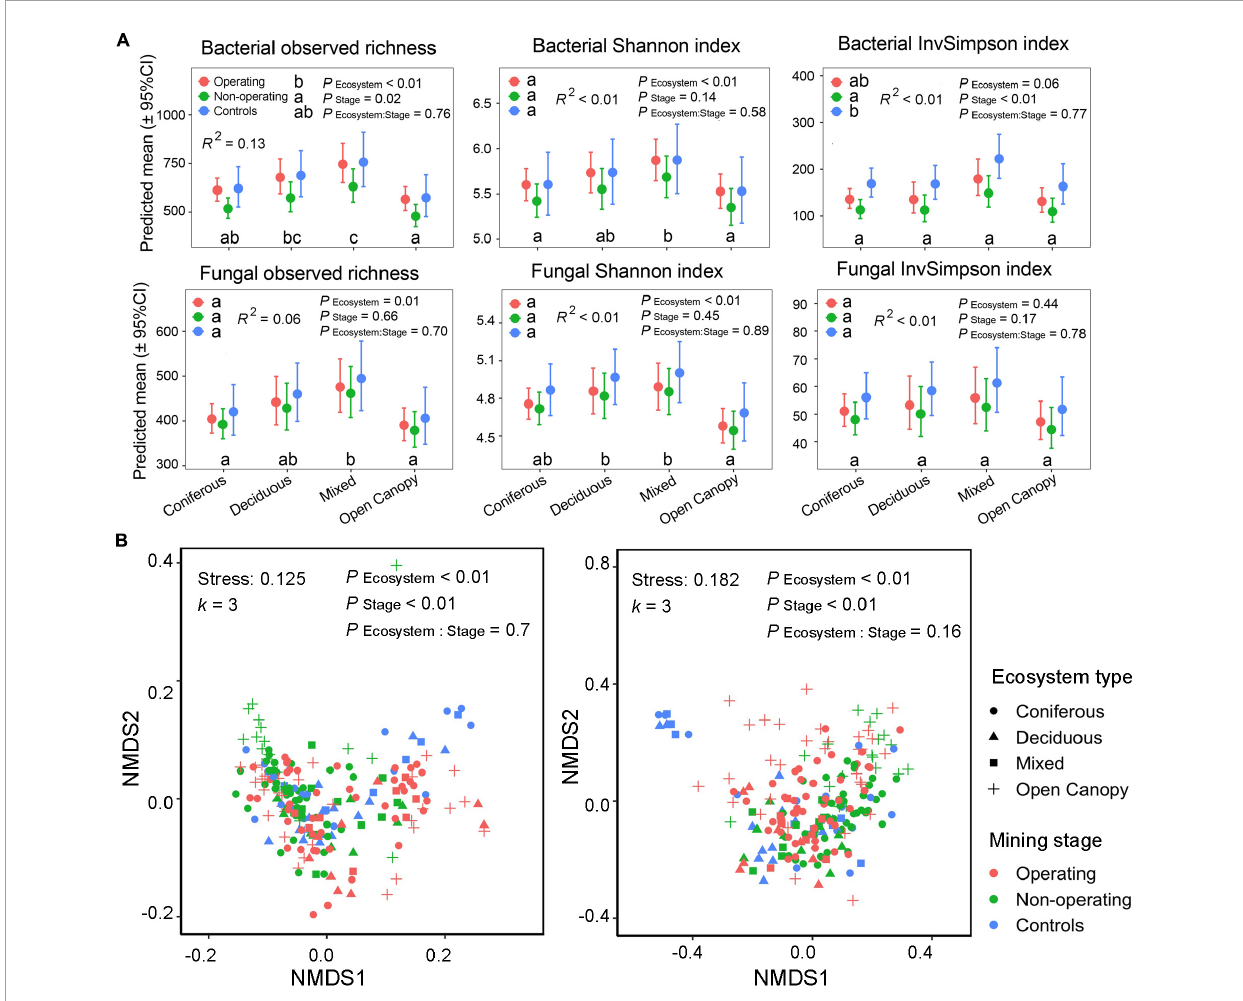
FIGURE2 Changes in the phyllosphere alpha and beta diversity in mine offsite landscapes. (A) Alpha diversity for both bacterial and fungal communities at different mining stages (plots surrounding operating sites, N = 92; plots surrounding non-operating sites, N = 78; plots in controls, N = 40) in four ecosystem types (coniferous forest, N = 101; deciduous forest, N = 33; mixed forest, N = 26; open canopy, N = 50). Points show means for all samples; bars show a 95% confidence interval around the mean. Different lowercase letters indicate significantly different means across mining stage and ecosystem type, respectively. P -value based on generalized linear mixed models (type II sum of squares) and Tukey HSD pairwise comparisons ( α = 0.05) were used to test the differences across ecosystem types and mining stages, respectively. (B) Beta diversity of bacterial and fungal community structure. Non-metric Multi-dimensional Scaling (NMDS) are based on Bray–Curtis dissimilarity. Tests in the top side of the panels present the results of